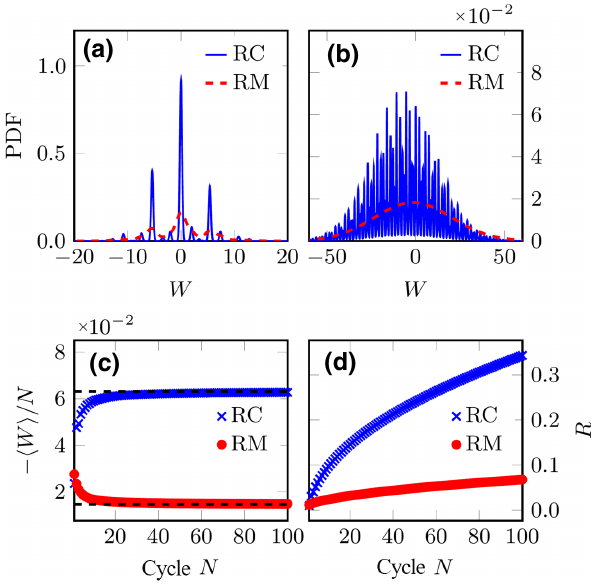
FIG. 4. (a) Plot of the work PDFs for repeated measurements (red) and repeated contacts (black) for N = 5 cycles and (b) does so for N = 100. Two-pointer and one-pointer repeated contacts give exactly the same PDFs of work due to the dynam- ical decoupling between populations and coherences during the thermalization process (see text for details). While for repeated contacts separate sharp lines with N -independent widths remain visible also for large numbers of cycles, the according terms for √ repeated measurements contribute with a width ∝ N and hence merge in a broad, practically Gaussian PDF. (c),(d) The average work output per cycle and the engine’s reliability, respectively. The horizontal black dashed lines in (c) correspond to the asymp- totic values of the average work per cycle obtained from the analytic maps described in Appendix B. The reliability scales as the square root of the cycle number N for large N . The repeated measurement scheme has a detrimental impact on the engine in terms of both average work output and reliability. The work strokes are characterized by nonadiabatic parameters α = 0.05, = 1 and (cid:11) = 3.7. The ϕ = 0. The energy gaps are chosen as (cid:11) c h bath parameters are β c = 0.25, β h = 0.025, the coupling con- stant γ = 0.025, and the thermalization times is taken such that τ = (cid:11) τ = 8. All pointer states initially are Gaussian θ = (cid:11) c c h h with a width of (cid:6) = 0.2. The engine is started in the according invariant state ρ ∗ [Eq. (43)] of the unobserved cycle dynamics given by Eq.